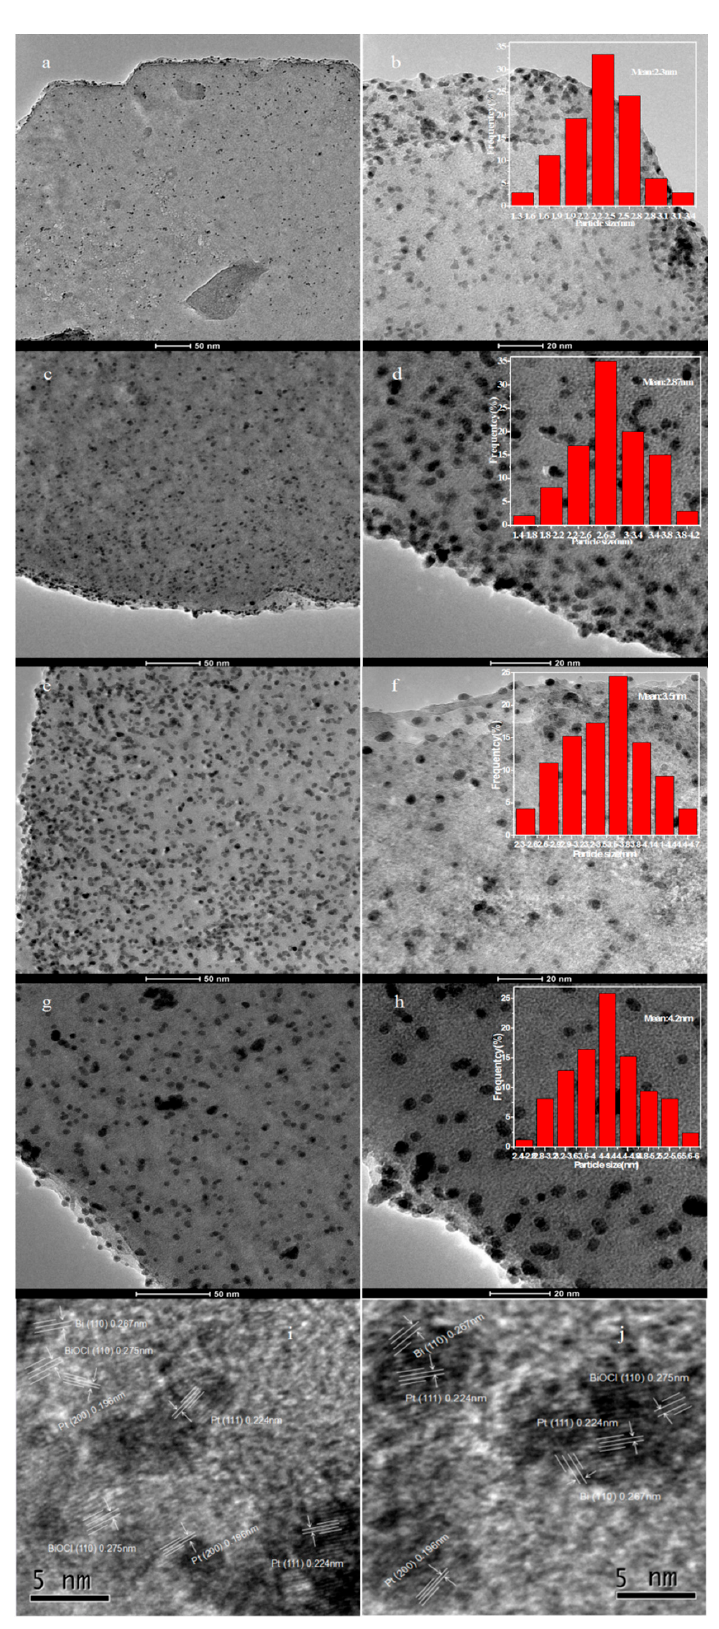
Figure 2. High-resolution TEM (HR-TEM) images and particle size distribution histograms for representative catalysts: ( a , b ) Pt/HT, ( c , d ) Pt–3Bi/HT, ( e , f , i , j ) Pt–7Bi/HT, and ( g , h )